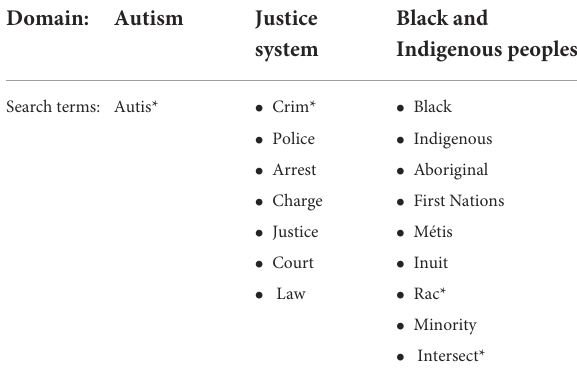
TABLE 3 Search terms for racialized autistic individuals and the